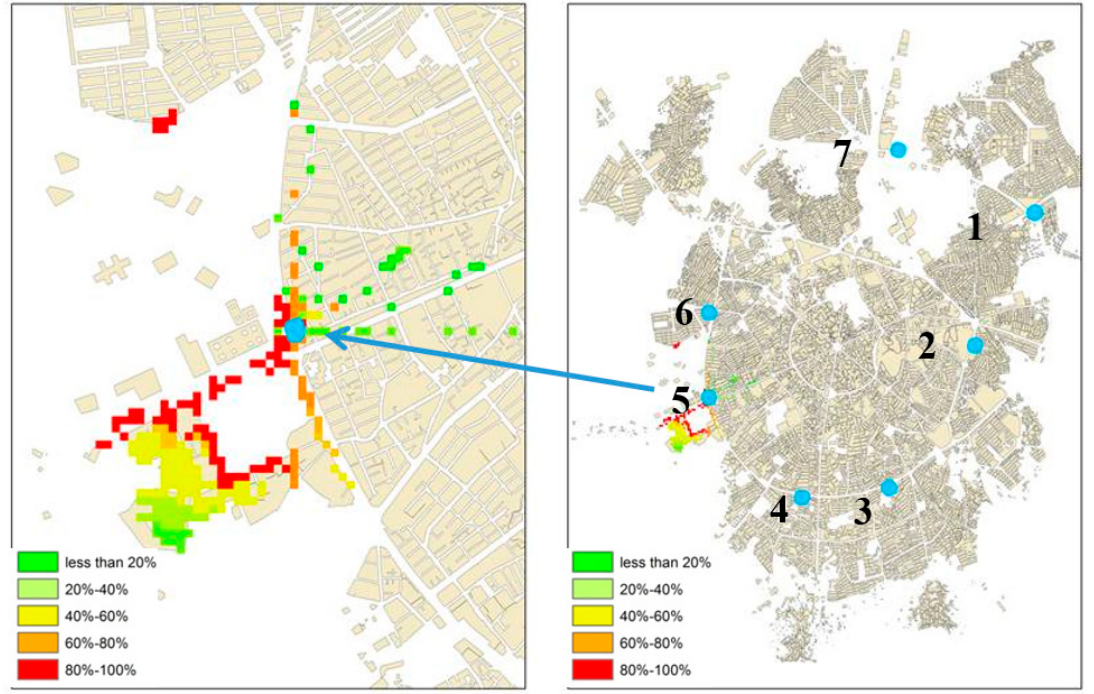
Figure 26. Visibility map of hypothetical tall building No. 5.